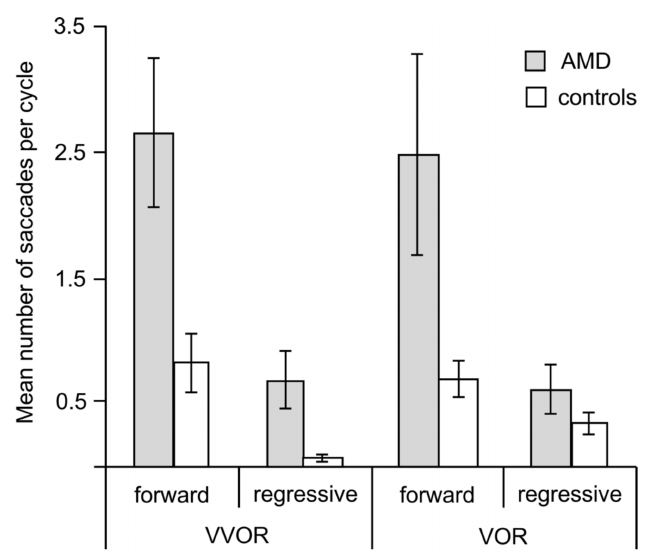
Figure 5. Mean number of saccades per cycle made by the AMD and control groups during VOR testing. Error bars are ± 1 SE.